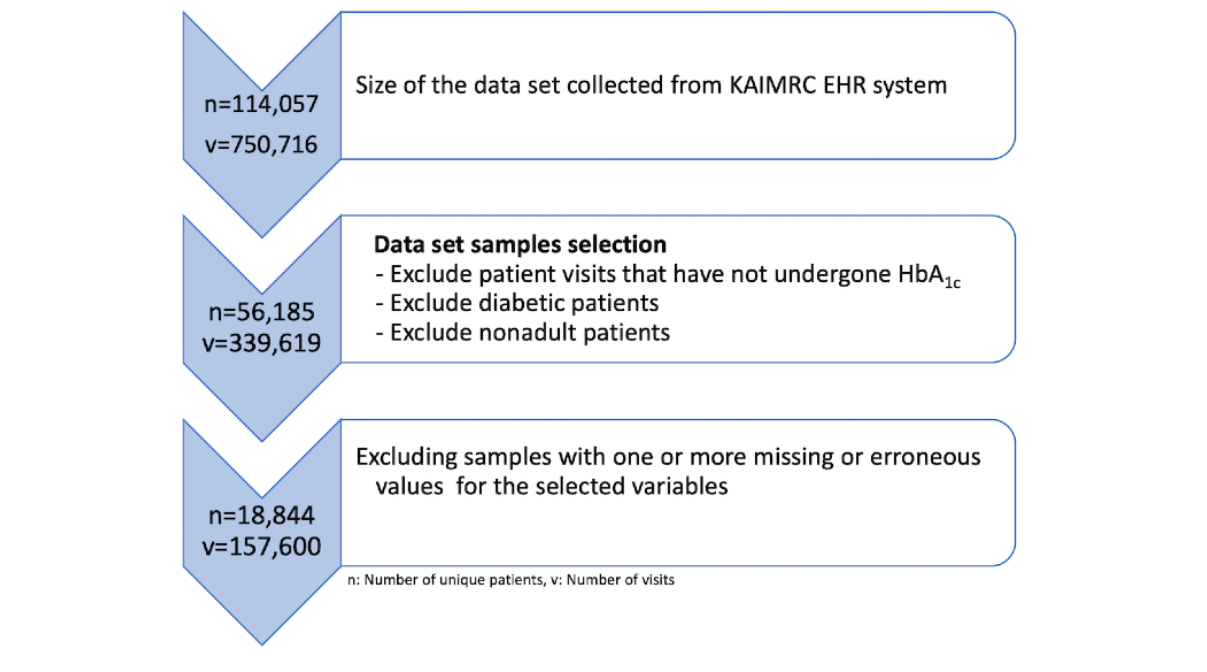
Figure 2. Details of the sampling approach performed on the KAIMRC data set. EHR: electronic health record; HbA 1c : glycated haemoglobin; KAIMRC: King Abdullah International Medical Research